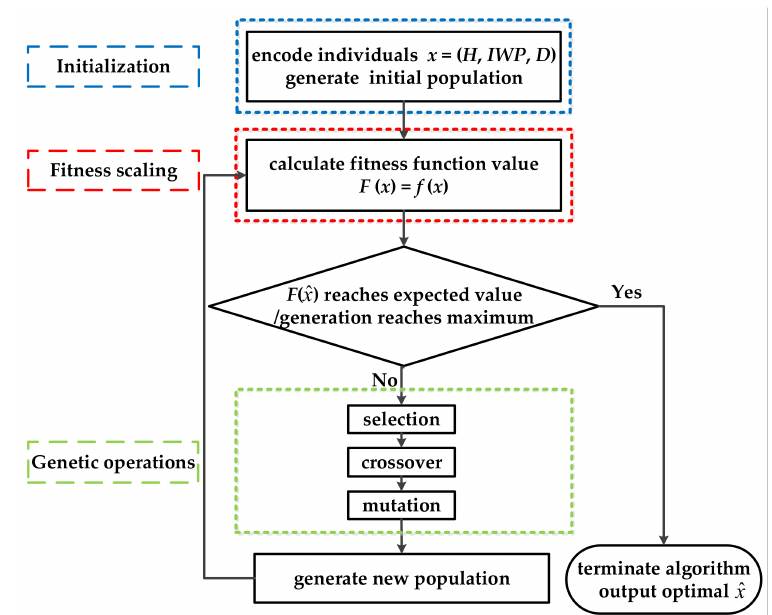
Figure 3. Process of ice cloud inversion based on the genetic